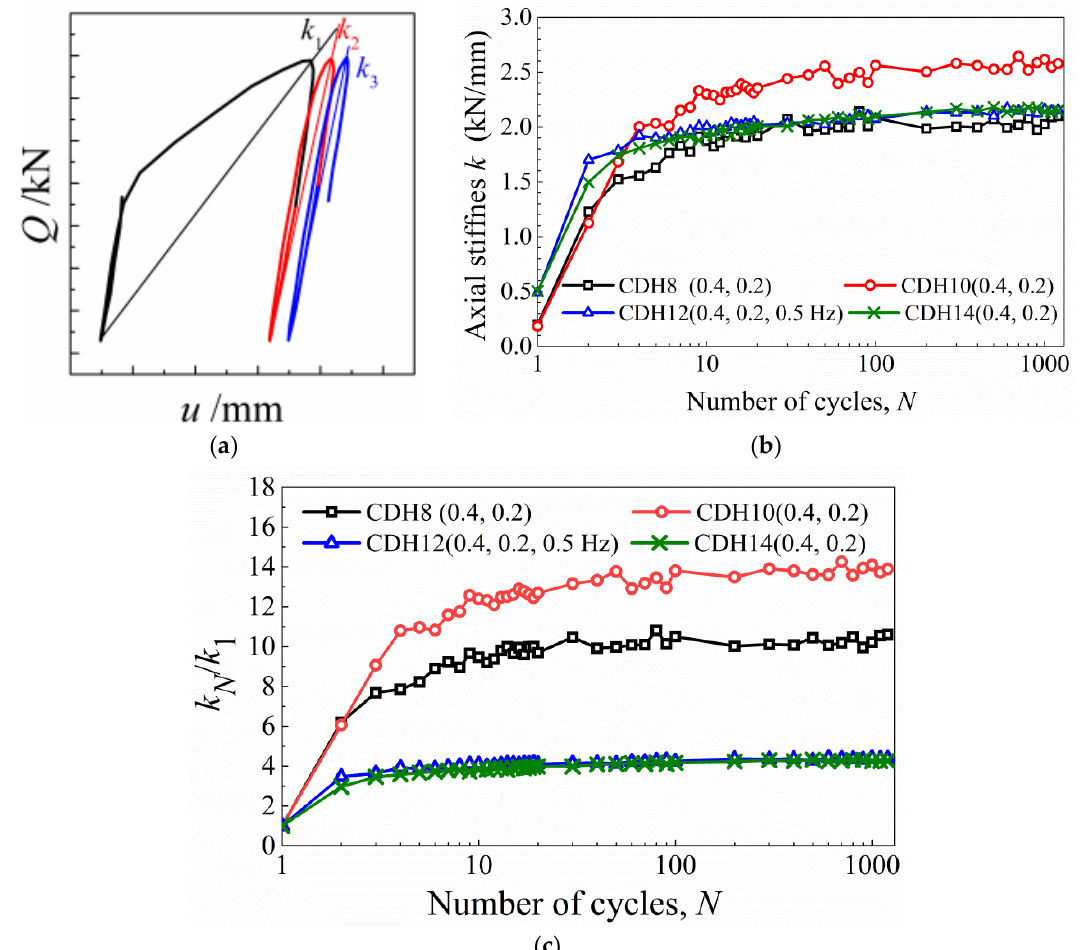
Figure 8. Axial stiffness for different embedment ratios: ( a ) definition of axial stiffness; ( b ) relationship of axial stiffness k and number of cycles N; ( c ) relationship of normalized axial stiffness k N / k 1 and number of cycles N.